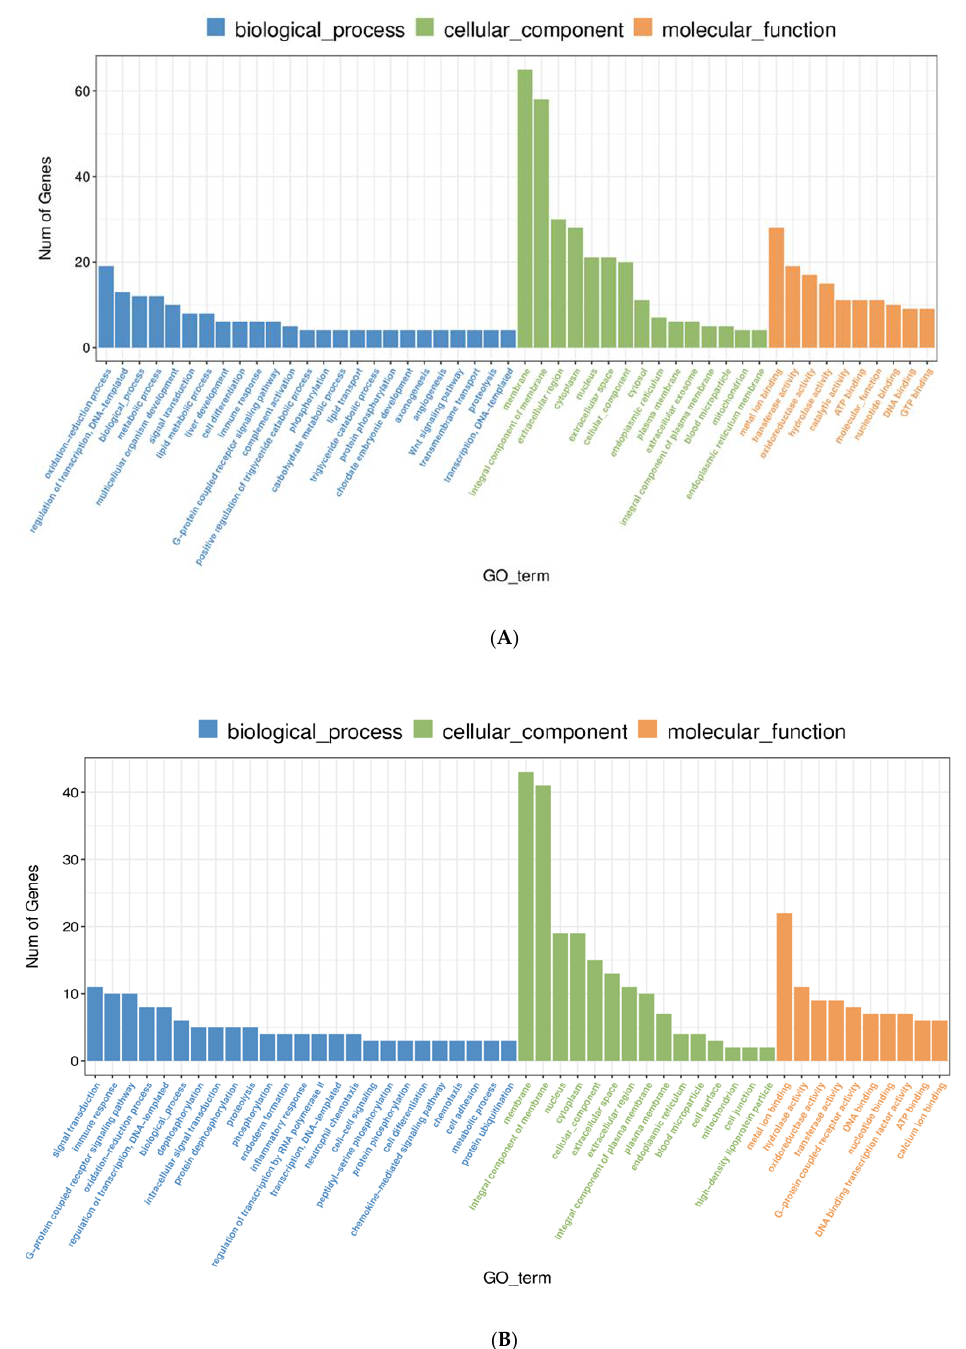
Figure 4. GO function enrichment analysis of DEGs in FWG vs. BWG, FWK vs. BWK groups. Top 20 enriched GO terms ( p ≤ 0.05) in categories of biological process, cellular component, and molecular function are presented for ( A ) FWG vs. BWG and ( B ) FWK vs.